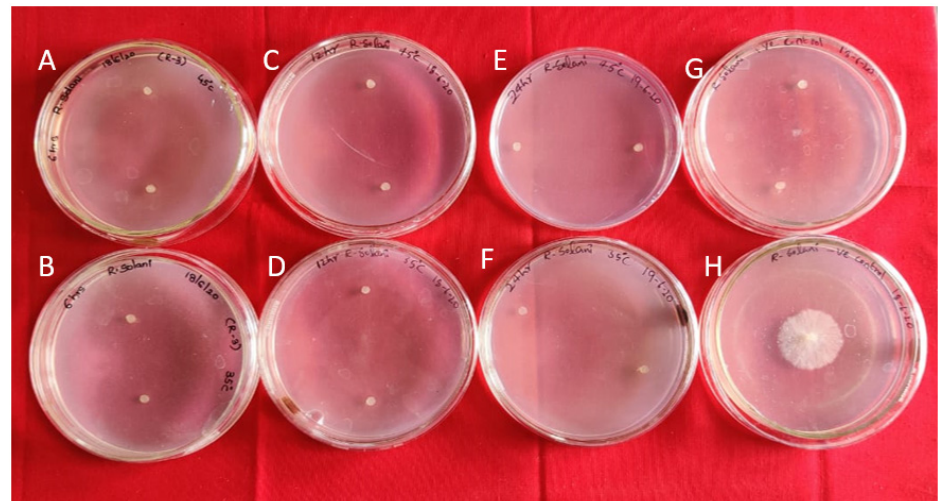
Figure 1. Antifungal activity of Bg_9562 protein at varied temperatures and incubation periods ( R. solani mycelial discs): ( A , B ) 6 h incubation at 45 °C, 35 °C; ( C , D ) 12 h incubation at 45 °C, 35 °C; ( E , F ) 24 h incubation at 45 °C, 35 °C; ( G ) untreated protein (positive control); ( H ) R. solani (negative control). Observations taken after 24 h.